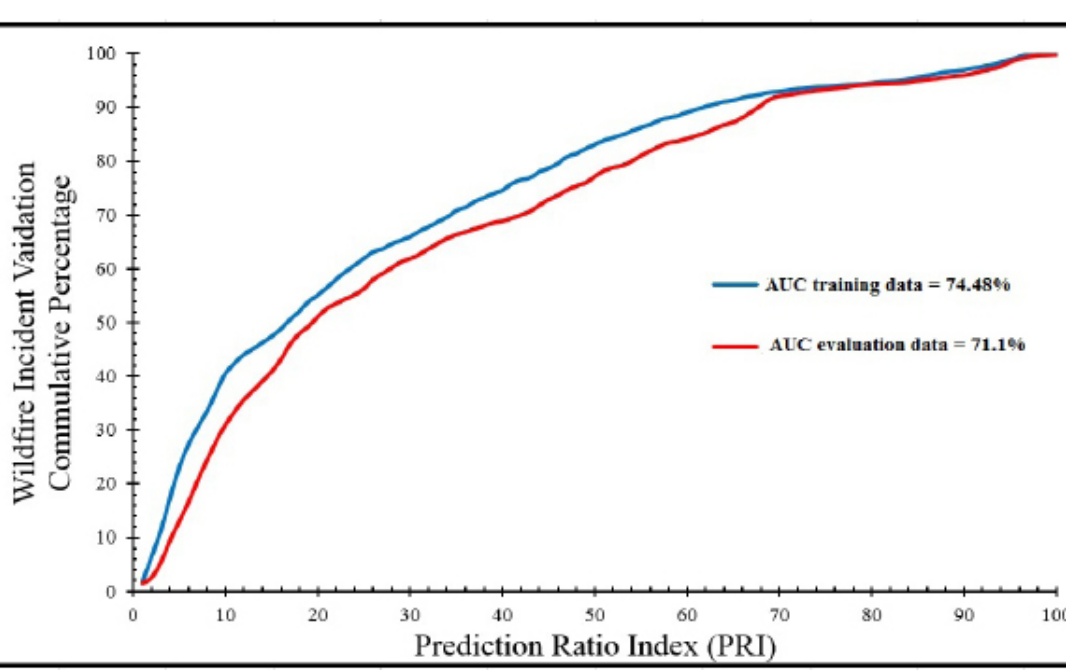
Figure 8. Fire hazard map evaluation using the AUC